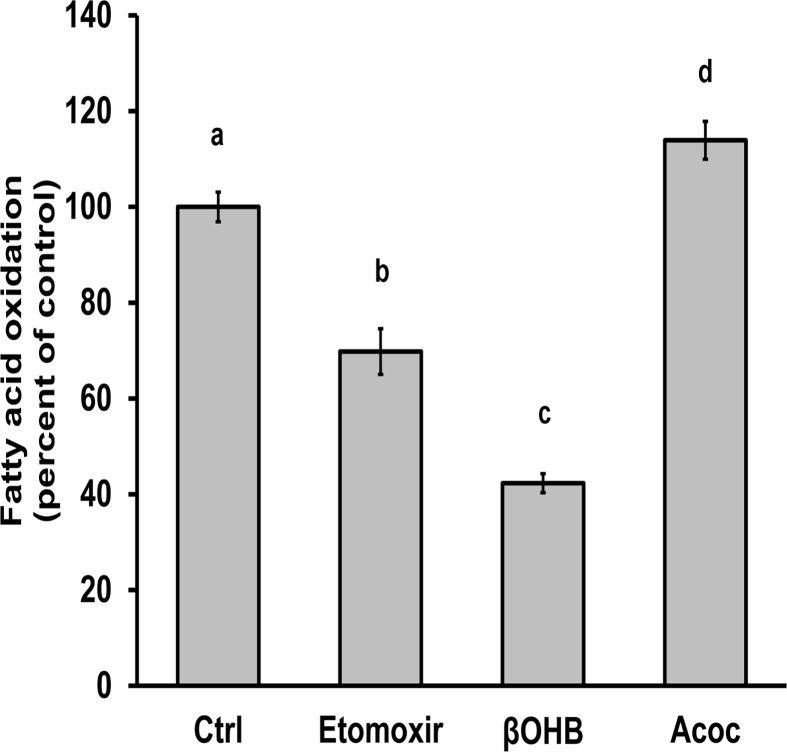
βOHB inhibits β-oxidation and Acoc accentuates β-oxidation.Freshly isolated hepatocytes were pre-incubated with 10 mM of a 50/50 mixture of l- and d-βOHB, 5 mM Acoc, or neither for 1 hour. 14C-labeled oleate was subsequently added for a 2 hour incubation in the presence of the treatments, 30 μM etomoxir, or neither (control, Ctrl). 14C from 14C-labeled carbon dioxide was detected and reported as a percentage of the control. Differences between all treatments are statistically significant (p < 0.05, ANOVA, Tukey’s posthoc analysis).